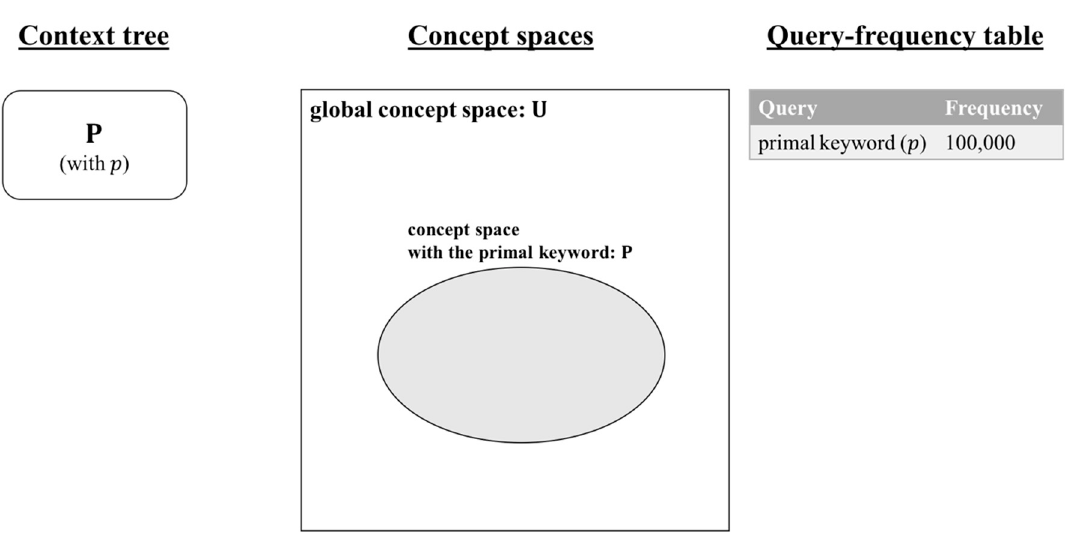
Figure 3. Extending the Context Tree with related keywords.